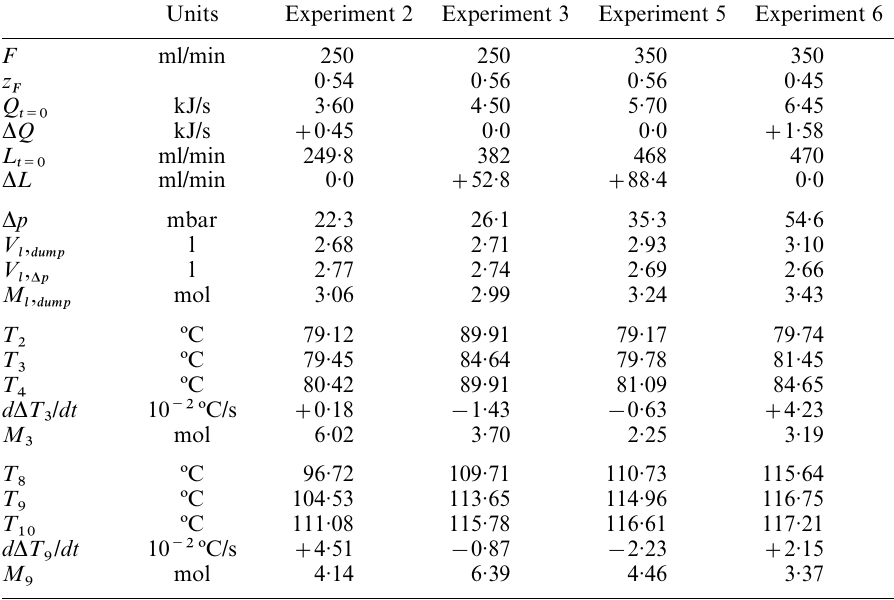
Table 3. Data for holdup estimation for experiments 2, 3, 5 and 6